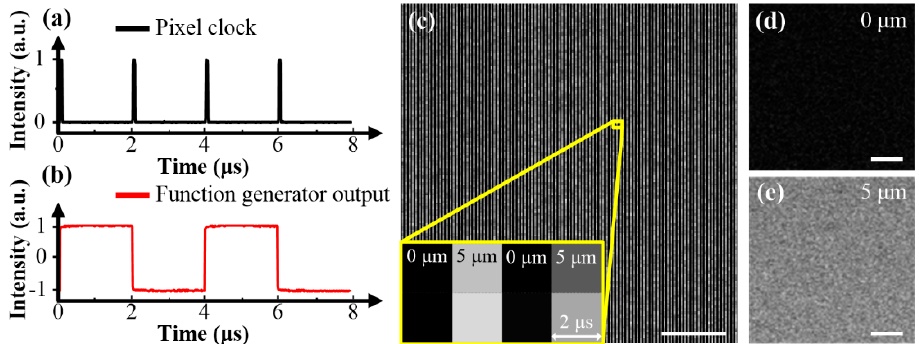
Figure 2. Demonstration of real-time multidepth multiphoton imaging using pixel-to-pixel focus-switching, 2 μ s/pixel, 200 × 200 pixels for ( c ), 100 × 100 pixels for panels ( d , e ). ( a ) The pixel clock from the microscope. ( b ) Pulse train from the function generator. ( c ) Autofluorescence image of proflavine in aqueous solution. Signals obtained from the depths of 0 and 5 μ m are displayed in different columns of the same image. The inset is a zoomed-in view of 2 × 4 pixels. ( d , e ) are autofluorescence images extracted from different columns of ( c ), corresponding to the depths of 0 and 5 μ m, respectively. The scale bars are 10 μ m.